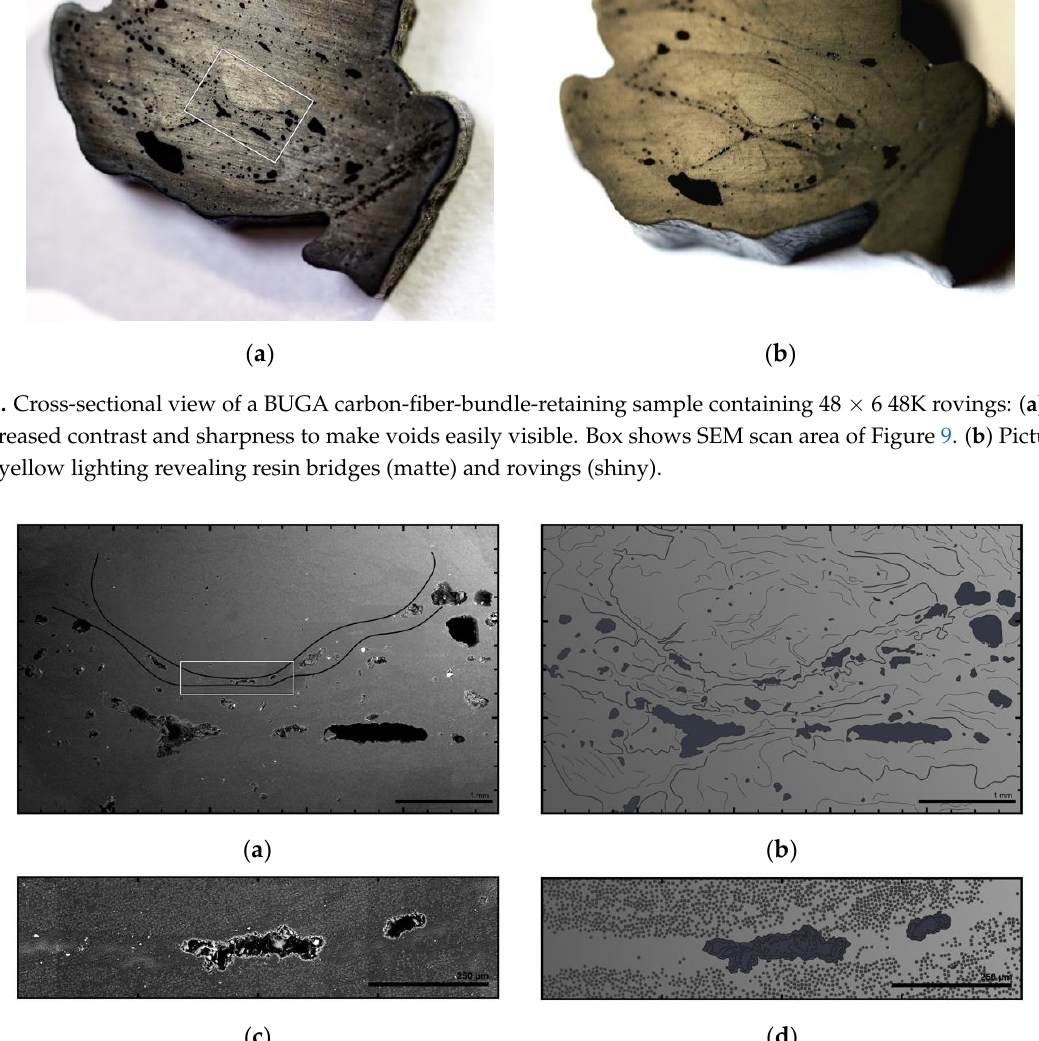
Figure 8. Cross-sectional view of a BUGA carbon-fiber-bundle-retaining sample containing 48×6 48K rovings: ( a ) picture with increased contrast and sharpness to make voids easily visible. Box shows SEM scan area of Figure 9. ( b ) Picture with oblique yellow lighting revealing resin bridges (matte) and rovings (shiny).